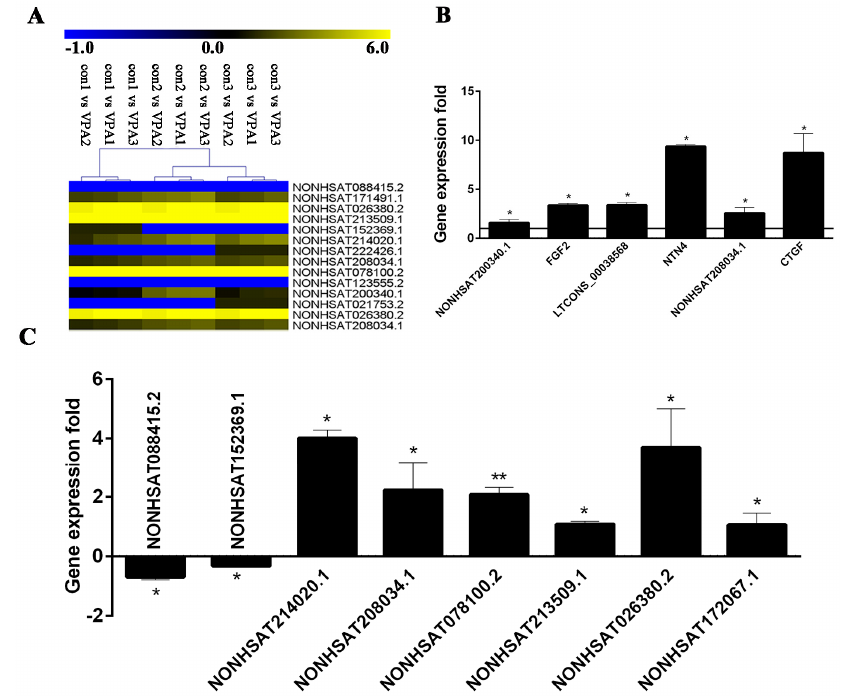
Figure 7. Verification of RNA-seq data. Heat maps show the differential expression fold (log2Ratio) for eight DE lncRNAs and three pairs of co-expressed lncRNAs-mRNAs between con (activated hHSC) and VPA (quiescent hHSC). Blue represents downregulation, whereas yellow indicates upregulation ( A ). The sequencing differential expression of CTGF , FGF2 and NTN4 is shown in Table 2. The expression folds of eight DE lncRNAs and three pairs of co-expressed lncRNAs-mRNAs in VPA (quiescent hHSC) were normalized against con (activated hHSC) ( B , C ). The relative expression levels were normalized to the expression amount of glyceraldehyde-3-phosphate dehydrogenase ( GAPDH ); (* p < 0.05, ** p < 0.01).